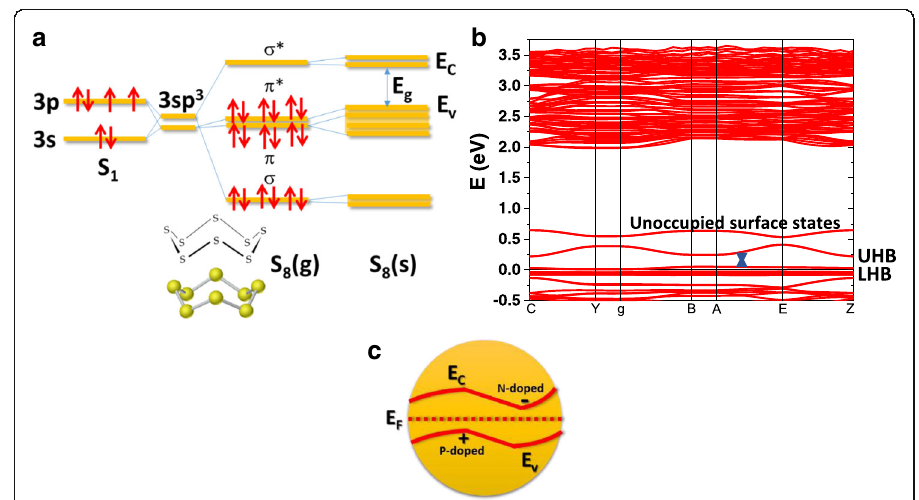
Fig. 3 Sulfur electronic structure; a electronic structure for an S atom, sp 3 hybridization, bonding and non- bonding molecular orbitals for S 8 (g) and band structure for S 8 (s) b first principles simulated band structure for monoclinic P2/c S 8 (s), containing 128 atoms and a simulated surface (where periodicity is broken). E c is bottom conduction band, E v is top valence band, UHB is upper Hubbard band, LHB is lower Hubbard band highlighting the Mott-Hubbard gap between filled and empty states of the surface ’ s dangling bonds; c Schematic representation of an S 8 (s) particle showing band bending (Bardeen 1947) at the surface allowing the Fermi level to be the same across the particle and forming a dipole (sulfur dielectric constant is 1.6 –